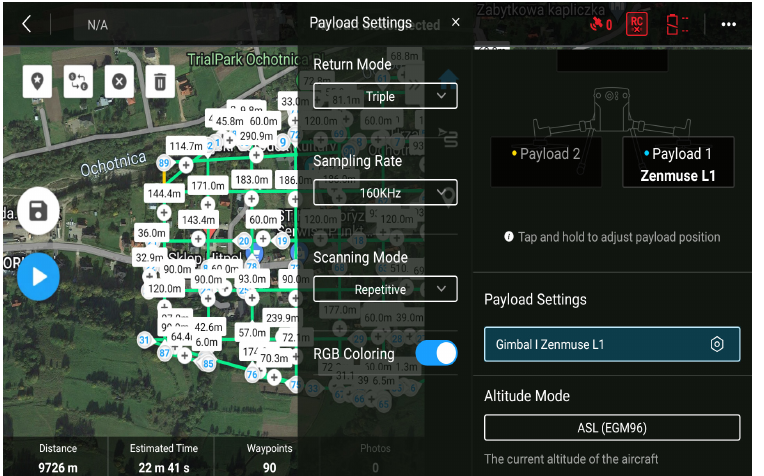
Figure 4. Flight project with basic parameters for the DJI Zenmuse L1 sensor—after importing to the DJI Pilot 2 software.